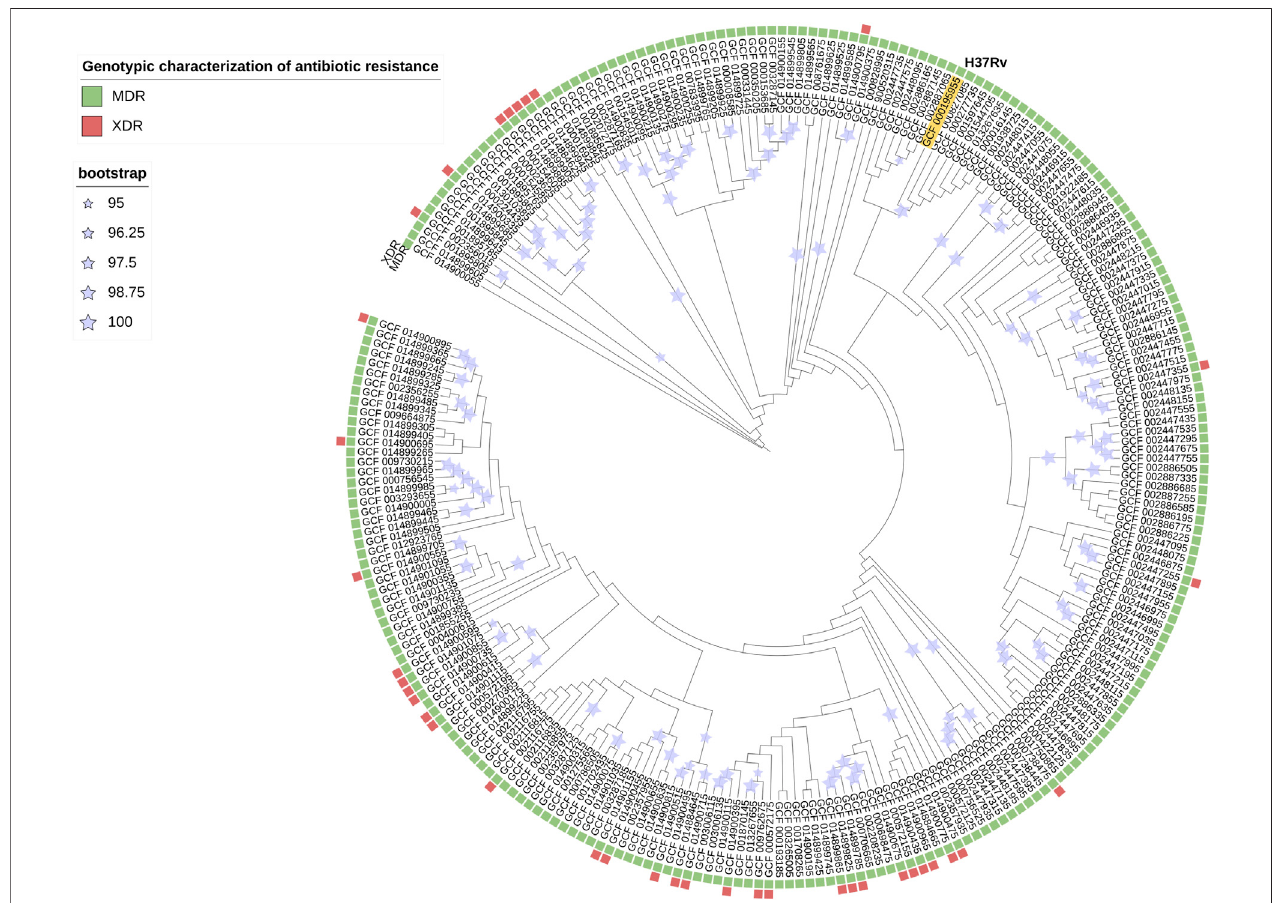
FIGURE2| Phylogenetictreepan-genomeMtbisaniTOLcircularvisualizationwiththebranchlengthandthebootstrapvaluesdisplayed.Thetreeisbasedonthe Maximum Likelihood topology of 254 strains representative of Mtb diversity and shows that length is proportional to nucleotide topology. Bootstrap values for clades correspondingtothemainMtbcladesareshown.Thecolorscorrespondtothedifferentgenotypiccharacterizationsofantibioticresistance(MDR=MultidrugResistant; XDR = Extensively Drug-Resistant).